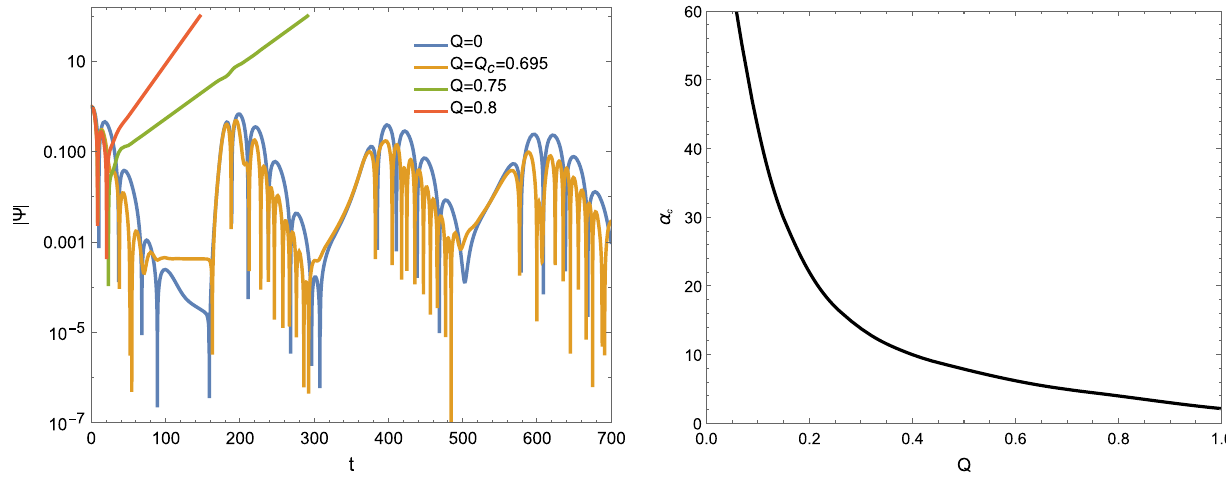
Fig. 3 Left: time evolutions of the scalar field perturbation in the linear level for α = 5 . 0 , Q = 0 . 5 and various values of B . Initial data of the − ( x − xc ) 2 perturbation is (cid:17)( t = 0 , x ) ∼ e 2 σ 2 with x c = 6 . 0 and σ = 6 . 0. Right: critical value of the coupling constant α c versus B for fixed Q = 0 . 5